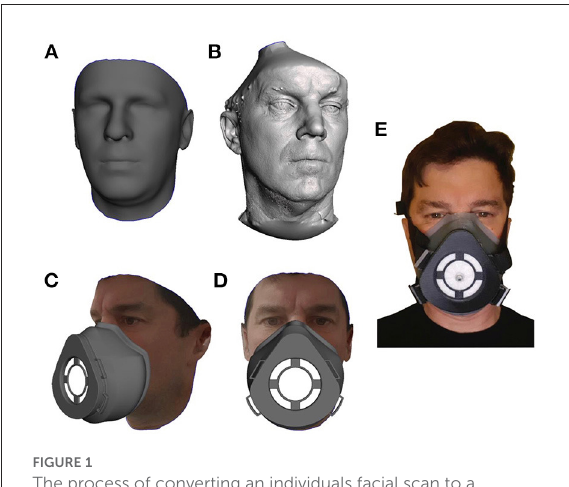
FIGURE1 The process of converting an individuals facial scan to a personalized 3D mask is demonstrated. (A) Is a 3D facial CAD Model generated using the Crisalix application while (B) is a 3D facial CAD Model generated from the Artec Eva scanning process. Both models are shown prior to any manipulation. (C,D) The full mask on a participant’s virtual face. (E) The final 3DPPE mask worn by the